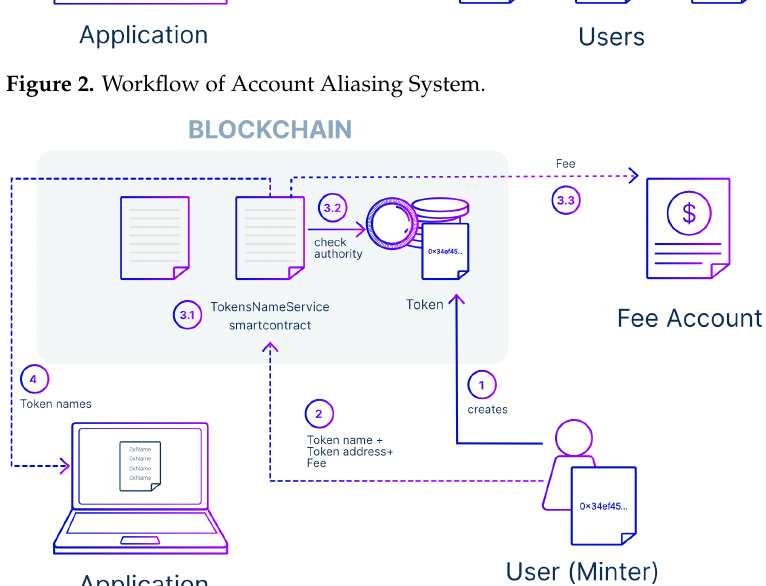
Figure 3. Workflow of Tokens Name